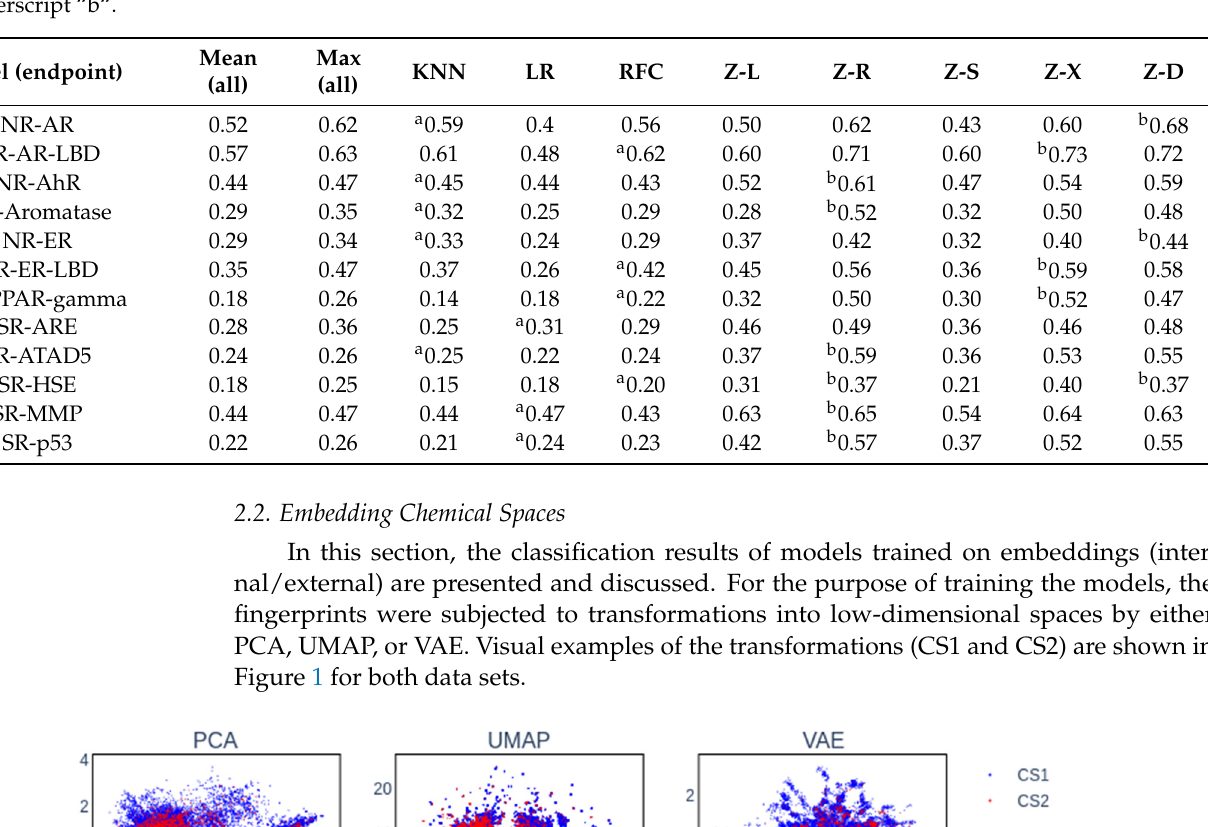
Table 1. A comparison of our baseline results trained on fingerprints to a similar study from Zhang et al. [37]. The results from Zhang are denoted with a “Z“, while the respective classifiers are as follows: L—lightGBM, R—random forests, S—support vector machines, X—XGBM, D—deep neural networks. The classifiers from this work are k-nearest neighbor classifier (KNN), logistic regression (LR), and random forests classifier (RFC), which are represented by their mean values per classifier, respectively. Additionally, the mean and max of all classifiers in this work are compared. The best baseline models in our work are marked with an superscript “a“, while the best models from Zhang are marked with an superscript “b“.